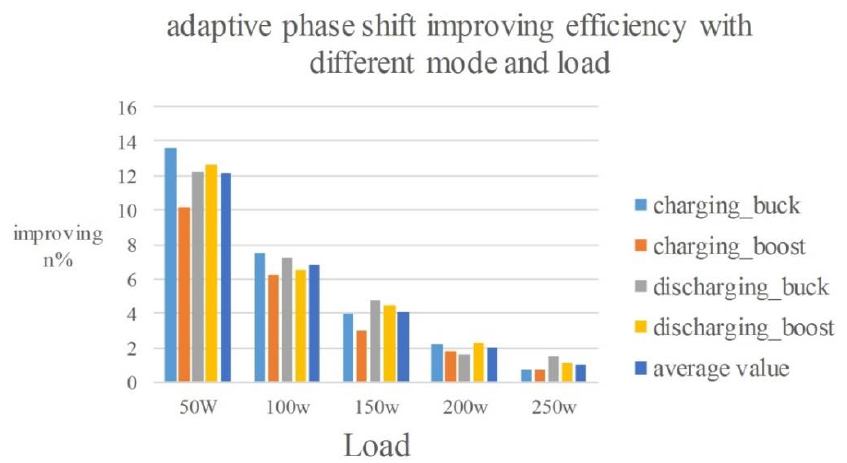
Figure 25. Efficiency improvement of the proposed APS control method under different operating modes.